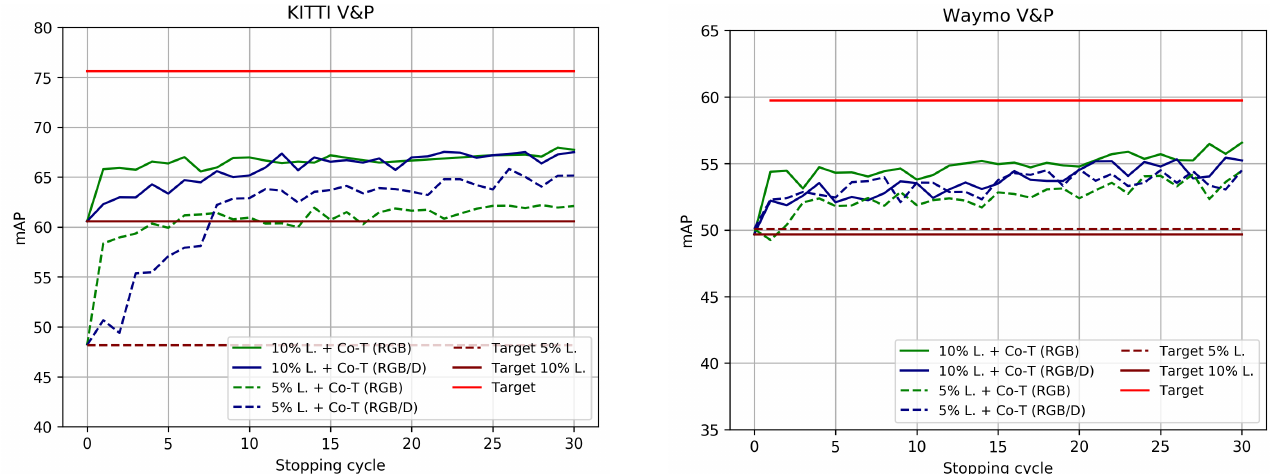
Figure 4. V&P detection accuracy of co-training approaches as a function of the stopping cycle. Co-T (RGB) and Co-T (RGB/D) refer to single and multi modal co-training, respectively. Target refers to the use of the 100% labeled training data, while Target p % L. indicates a lower percentage p P t 5,10 u of labeled data available for training. Accordingly, p % L. + Co-T (view), view P {RGB, RGB/D}, are combinations of those. These plots complement the results shown in Table 4.